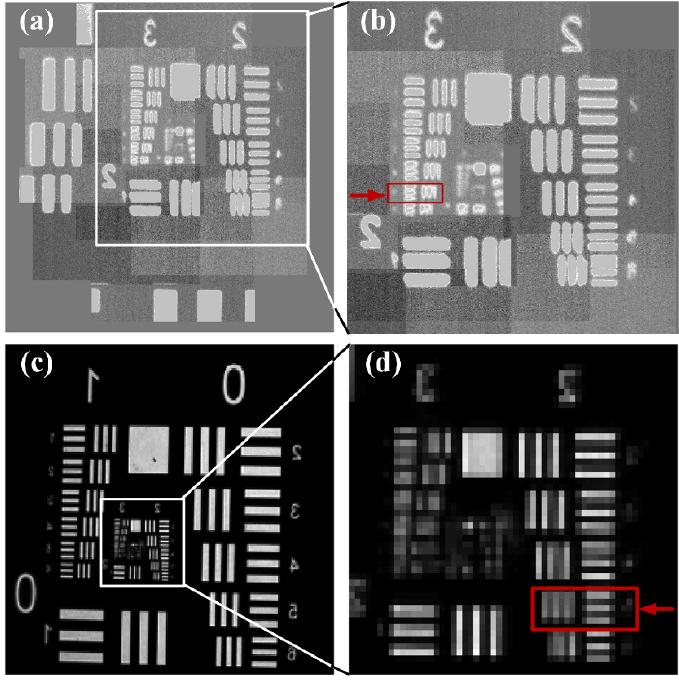
Figure 9. Comparison of stitching imaging and direct imaging with a CCD camera. ( a ) Original stitching image obtained by the proposed imaging technique; ( b ) enlarged middle view of the stitching image; ( c ) direct image obtained by the CCD camera; ( d ) enlarged CCD image of the same area as ( b ).